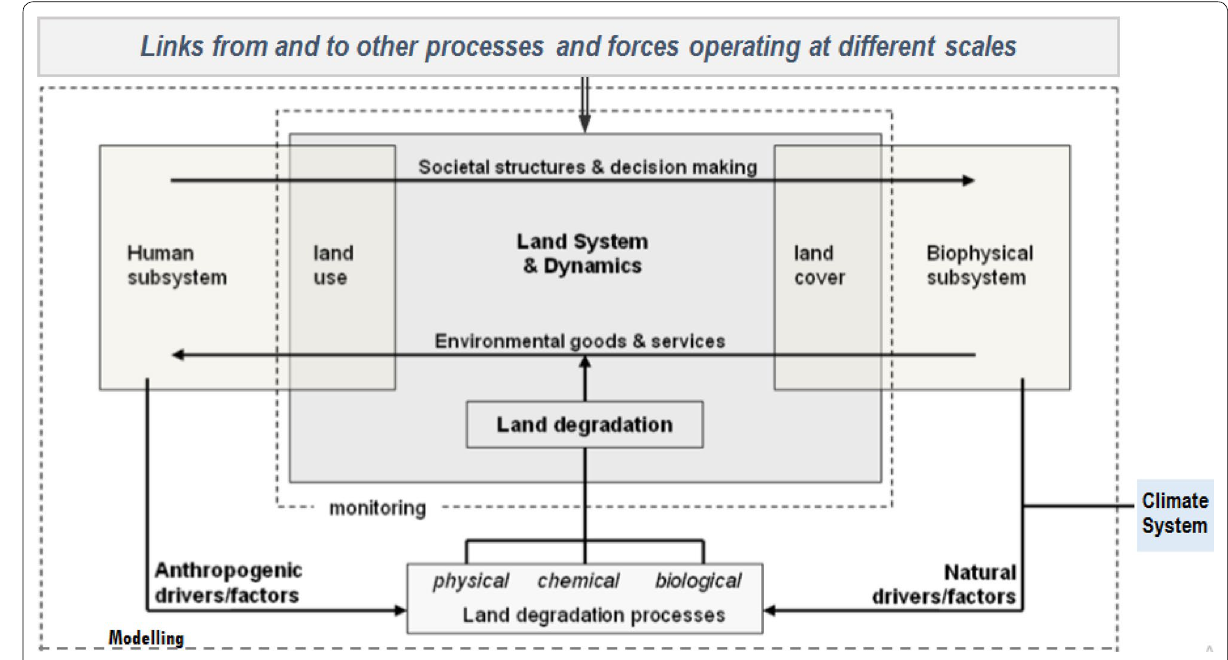
Fig. 3 Land degradation within the land change science framework. Source: De Jong et al. (2011), Turner II et al.